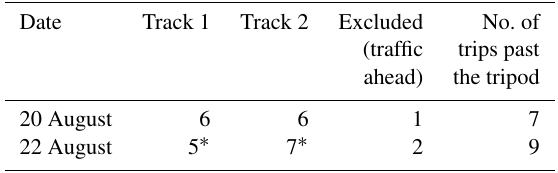
Table 1. The number of measurement passes performed on each measurement track on 20 and 22 August.